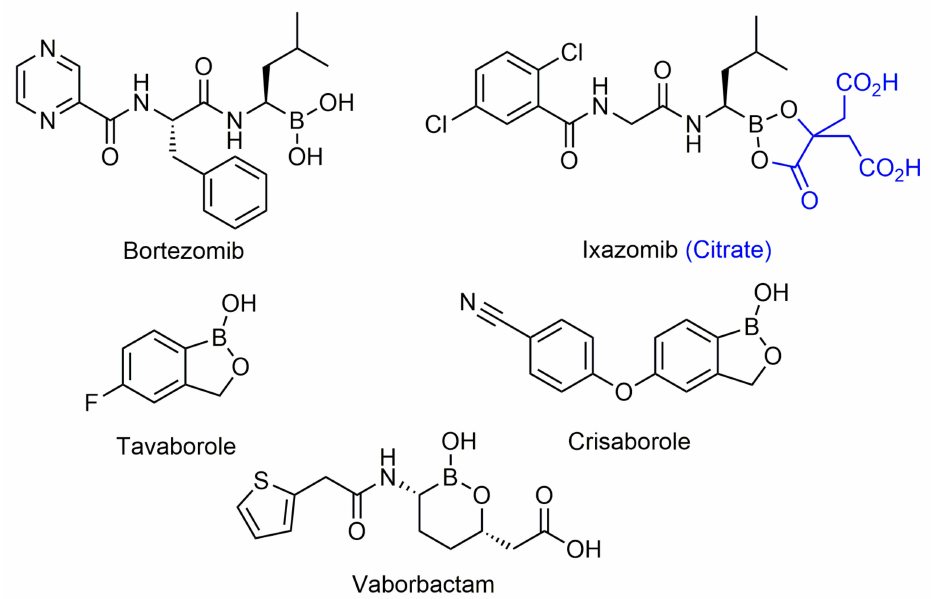
Figure 1. FDA-approved boron-containing